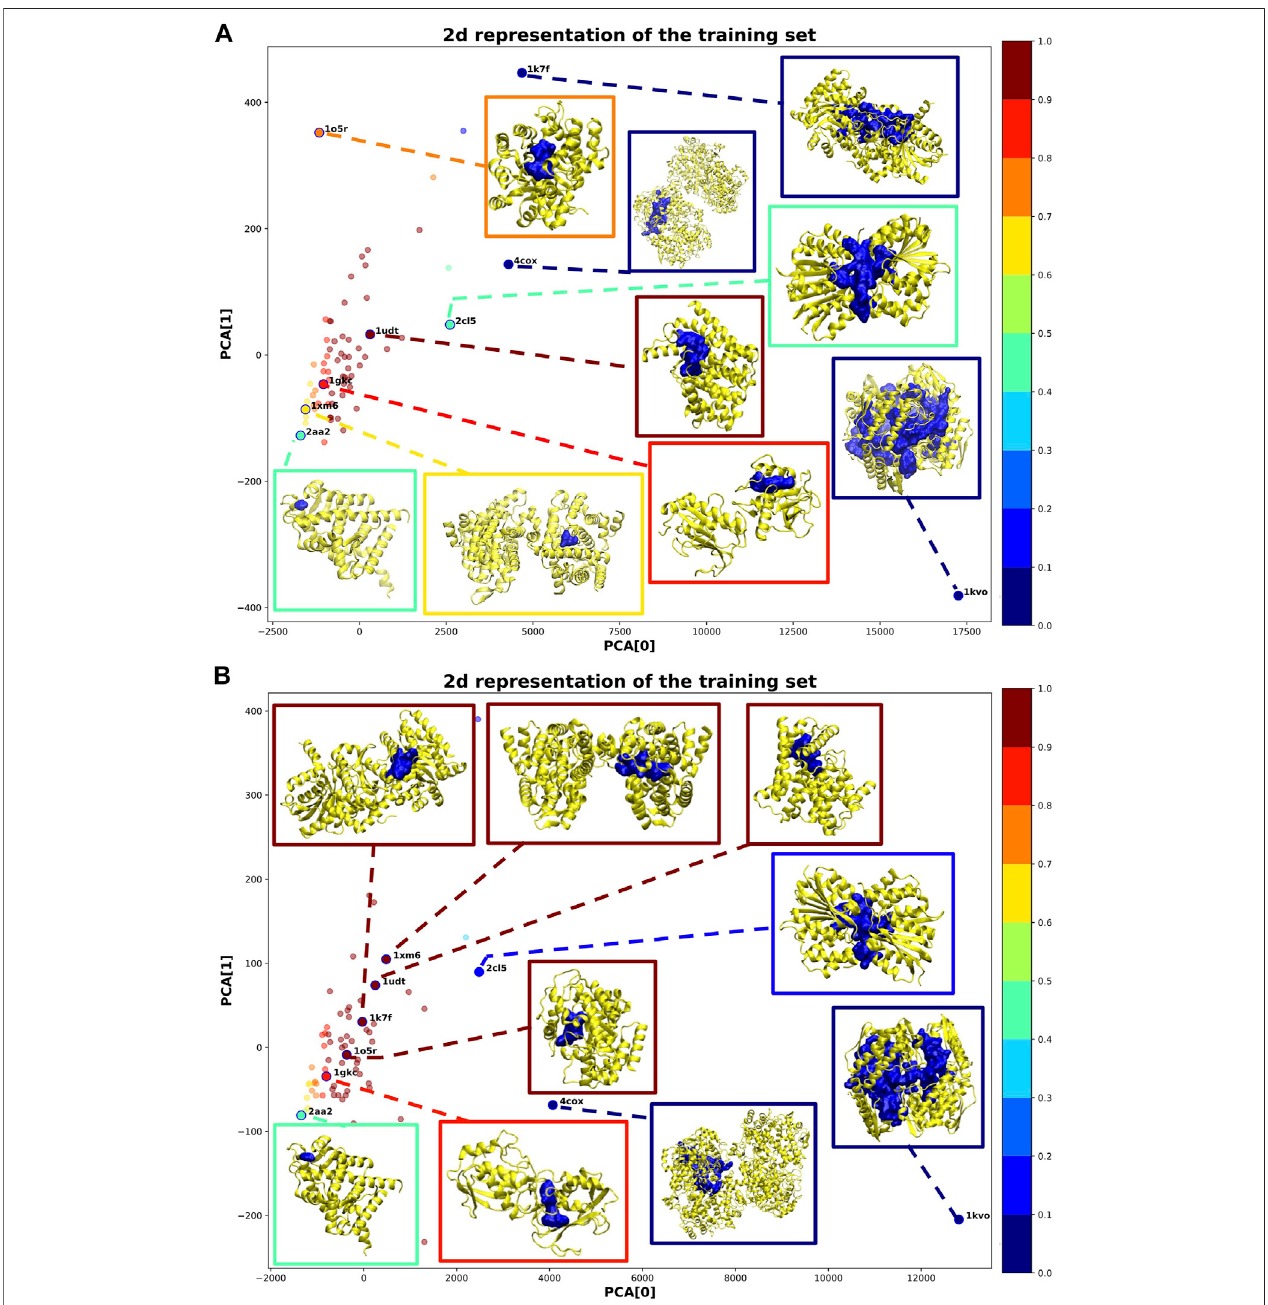
FIGURE 4 | 2D representation of the training samples via PCA dimensionality reduction. Each point corresponds to a training sample (protein-binding site). The color of each point corresponds to the probability assigned by IVDD (graded according to the color map on the right). For some training samples, the corresponding 3D structure is shown. (A) is without hydrogen atoms, whereas in (B) hydrogen atoms were added.